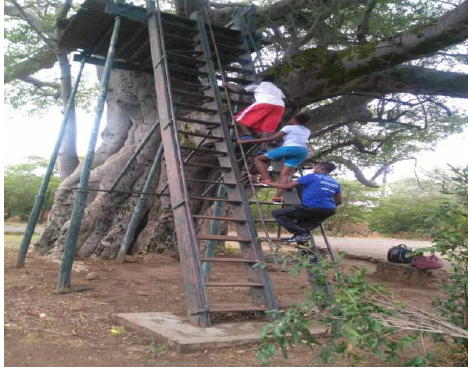
Figure 7: Baobab gathering by climb